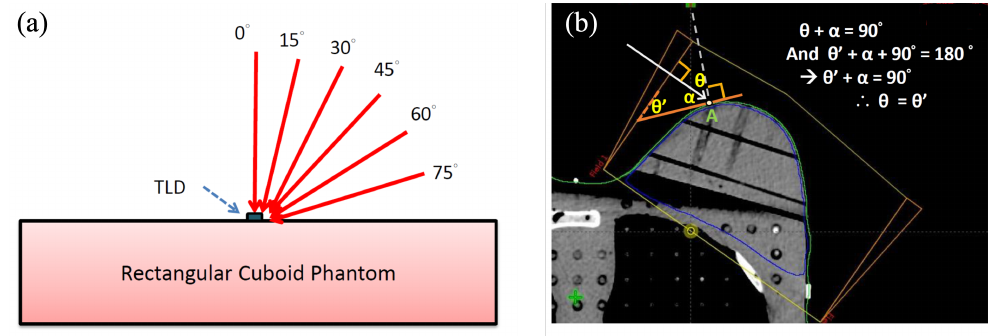
Figure 2. ( a ) Illustration of a one-direction beam from the different incident angles. TLD was put on the surface of the cuboid phantom. ( b ) The theoretical incident angle between the beam angle (white arrow line) and point A is θ (orange line: the tangent line at point A). Under the derivation described above, the angle θ ’ is equal to angle θ . It is more easily checked by cTPS for angle θ ’, which is just between the tangent line and the field plane